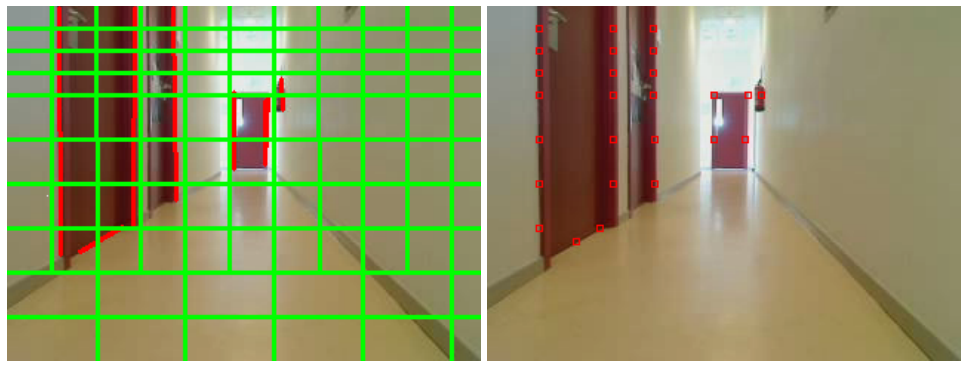
Figure 10. Image grid (left) and points selected (right).